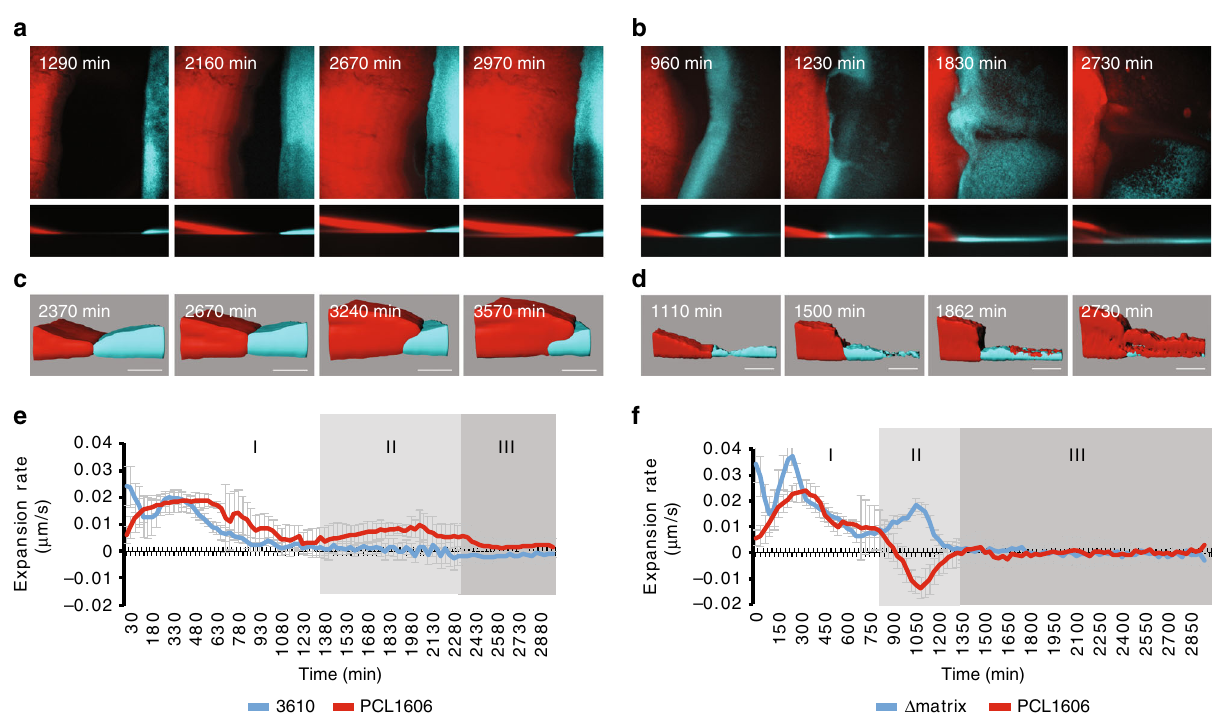
Fig. 3 Colony expansion rates vary during the interaction. Red lines represent PCL1606 and blue lines indicate Bacillus strains. a – d CLSM time-course experiments of the interactions between a , c PCL1606 and 3610 and b , d PCL1606 with Δ matrix. a , b show the main steps during the interactions as a sum of the projections and in z axis. c , d show the most important points since both bacteria have interacted. e , f Expansion rates of the Bacillus and PCL1606 strains during the interactions can be divided in three different stages (I, II, III). Red lines represent PCL1606 and blue lines indicate Bacillus strains. e shows the expansion rates of 3610 and PCL1606 during the interaction. f shows the expansion rates of Δ matrix and PCL1606 during the interaction. Average values of four biological replicates are shown, with error bars representing SD. Scale bar = 100 µ m. Source data are provided as